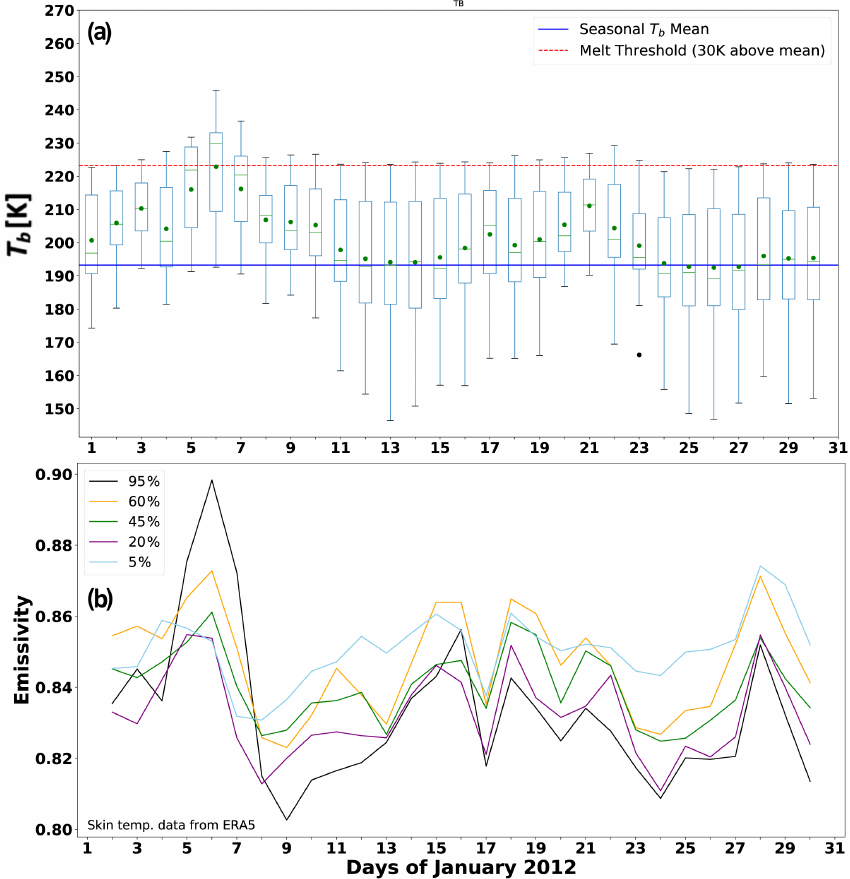
Figure 7. As in Fig. 3 but over the Pine Island and Thwaites Glacier region throughout January 2012. The five estimates of surface emissivity in panel (b) sampled from the region are referenced to the maximum T b value in the region on 6